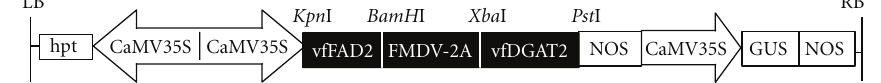
Figure 1: Construction of vfFAD2-vfDGAT2/ pCAMBIA1301 using the FMDV2A sequence. LB: the left T-DNA border; hpt: hygromycin gene; CaMV35S: cauliflower mosaic virus 35S promoter; vfFAD2 : tung tree; linoleic acid desaturase gene FMDV2A : foot-and-mouth disease Virus 2A sequence; vfDGAT2 : diacylglycerol acyltransferase gene; NOS: NOS terminator; GUS: beta-glucuronidase; RB: the right T-DNA border. Table 1: Primer sequences of vfFAD2, vfDGAT2 , and FDMV -2 A .